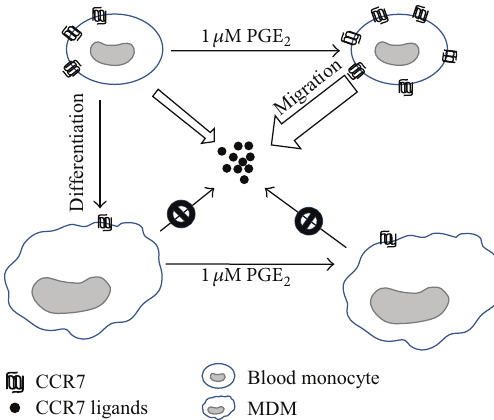
Figure 8: Schematic depicting CCR7 expression and functionality on human monocytes and